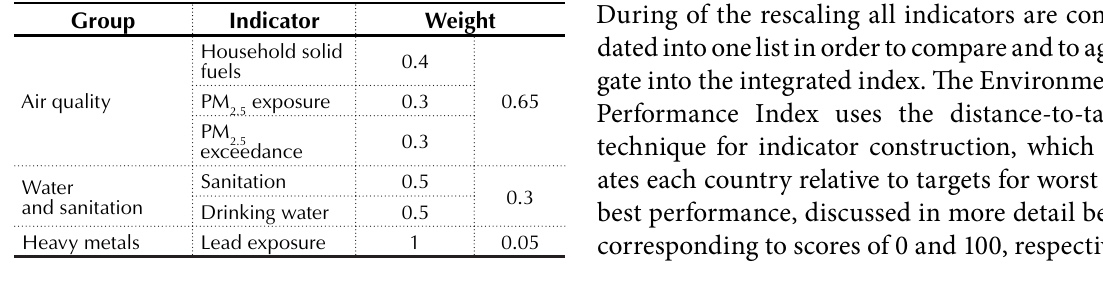
Table 3. Environmental Performance Index: the main indicators of policy objective – ecosystem